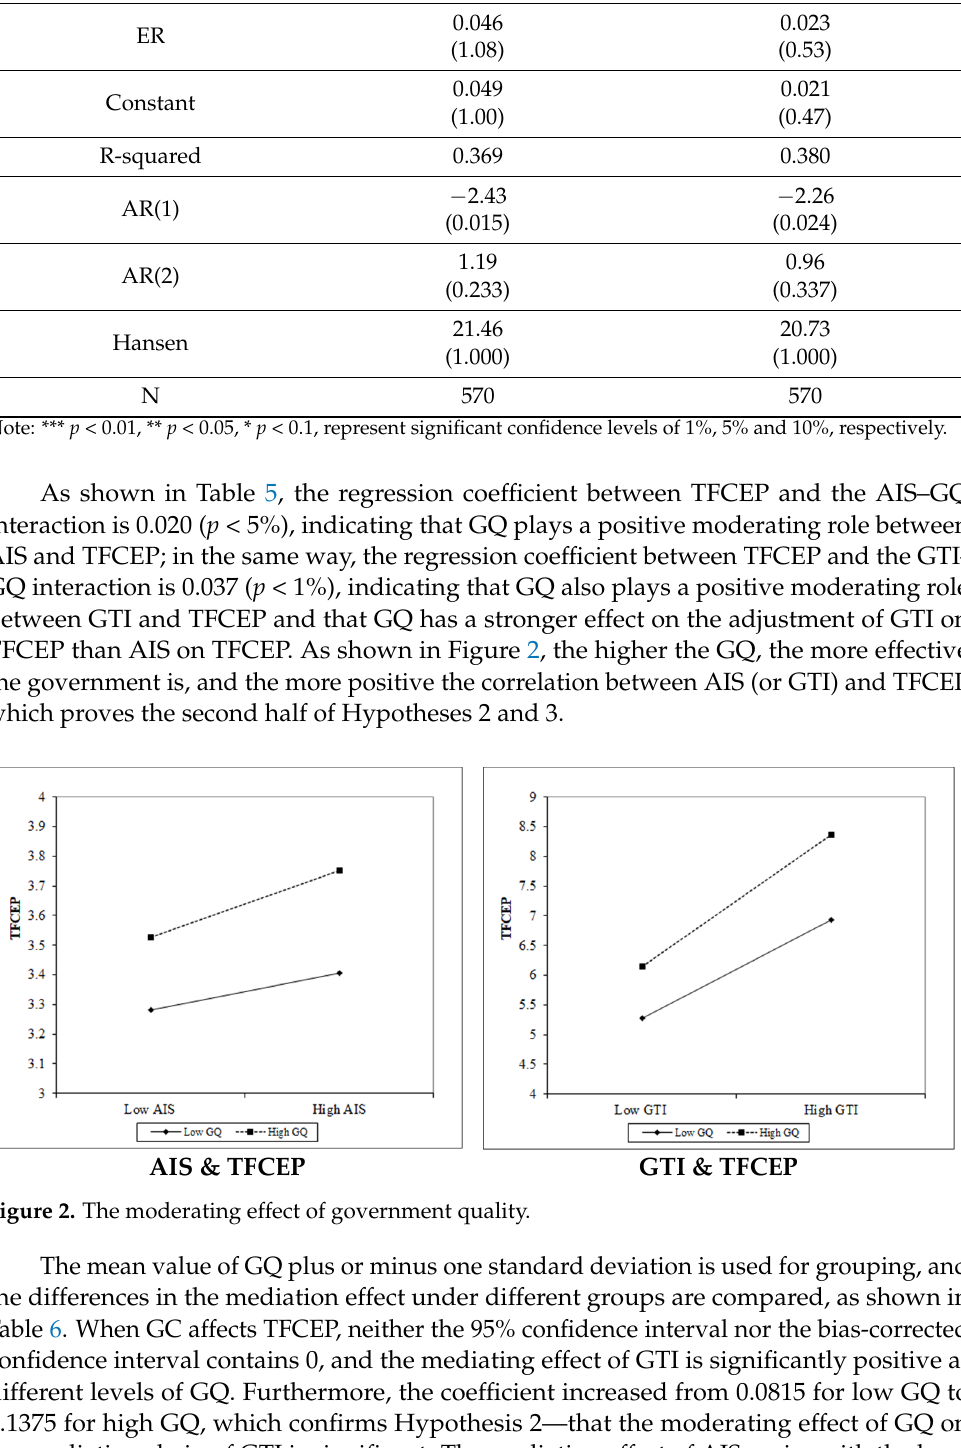
Table 6. Bootstrap test for the mediating effect of moderation.